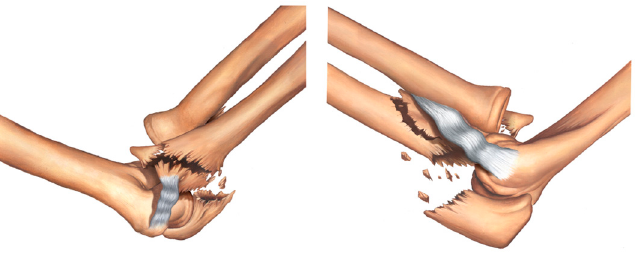
Figure 8. Type IV fracture—transolecranon fracture of the proximal ulna with associated fracture of the sublime tubercle, supinator crest, and coronoid process.